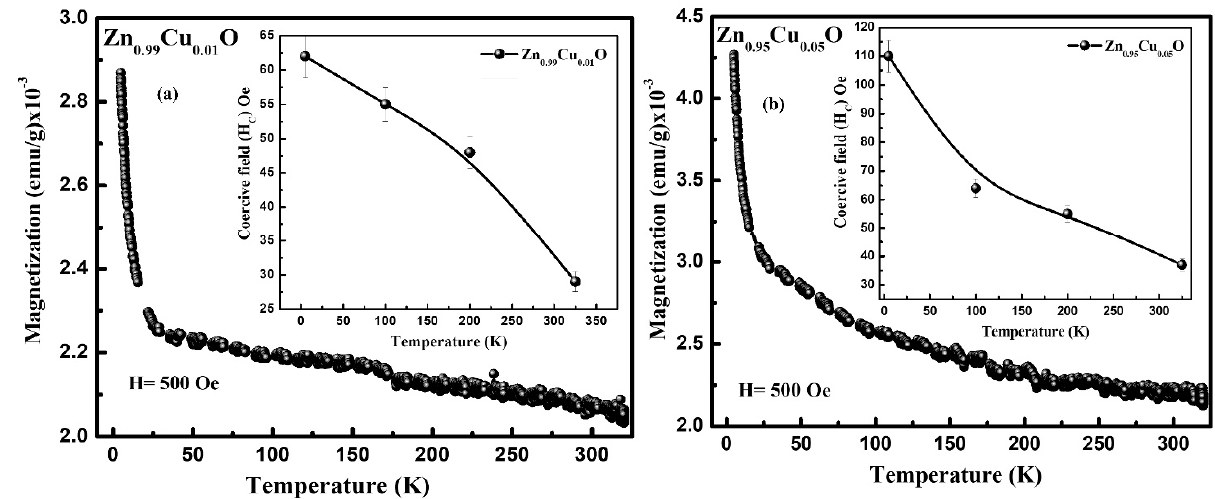
Figure 8. ( a ) Field cooled magnetization vs. temperature curve of Zn 0.99 Cu 0.01 O nanostructures. Inset shows the H C of Zn 0.99 Cu 0.01 O nanostructures at different temperatures. ( b ) Field cooled magnetization vs. temperature curve of Zn 0.95 Cu 0.05 O nanostructures. Inset shows the H C of Zn 0.95 Cu 0.05 O nanostructures at different